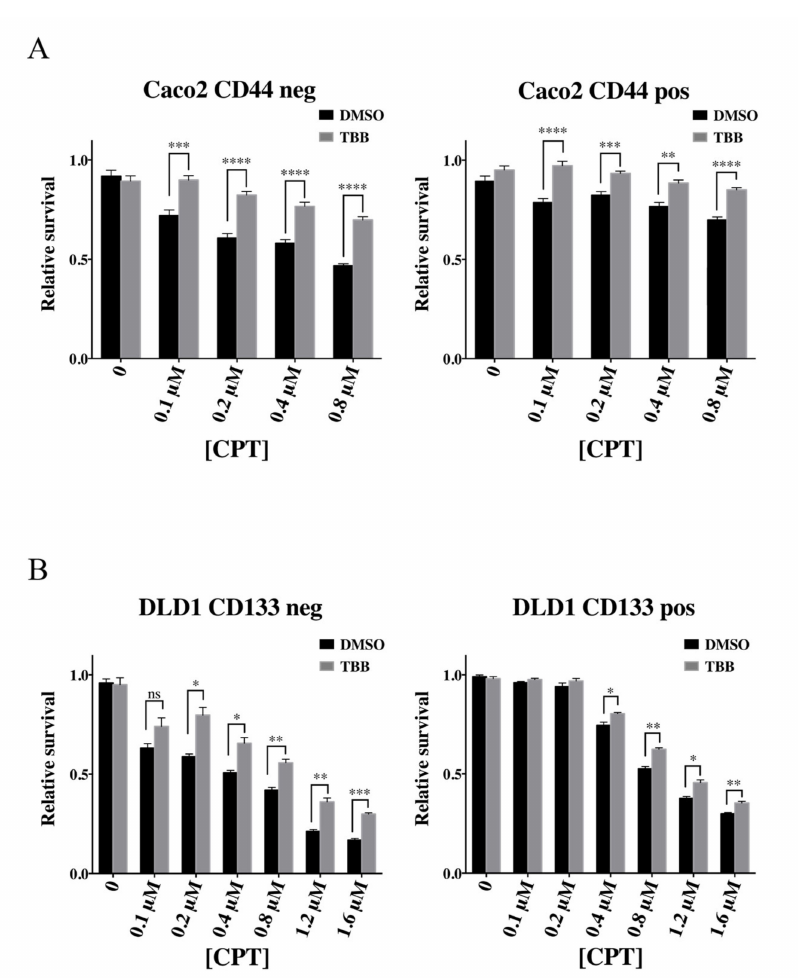
Figure 2. Camptothecin sensitivity of colon cancer cell subpopulations with or without treatment with 4,5,6,7-tetrabromobenzotriazole (TBB). ( A ) Survival assay of the Fluorescence Activated Cell Sorting (FACS) sorted non-CSC-like (CD44 negative, “CD44 neg”, left graph) or CSC-like (CD44 positive, “CD44 pos”, right graph) cells of Caco2 after treatment with DMSO or 10 µ M TBB. The sorted cells were plated and treated with DMSO or indicated concentrations of CPT for 72 h before the percentage of viable cells was measured using the PrestoBlue viability assay. Data were normalized to the viability of the cells without CPT (DMSO) and plotted as mean +/ − standard error of the mean (SEM). **** p < 0.0001, *** p < 0.001; ** p < 0.01, Welch’s t -test, n = 6. ( B ) Same as (A) except that DLD1 cell subpopulations were analyzed. *** p < 0.001; ** p < 0.01; * p < 0.05, Welch’s t